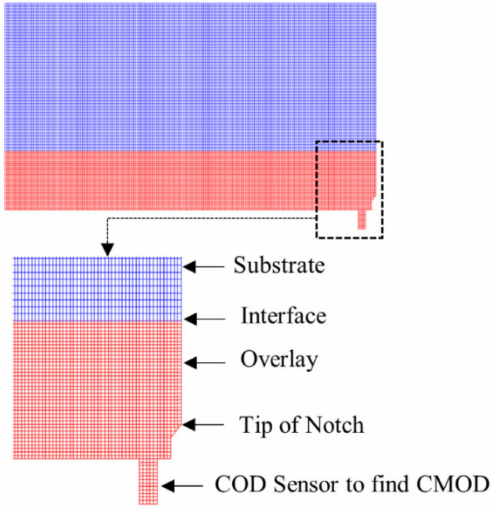
Figure 11. Substrate–overlay composite beam model in FEM